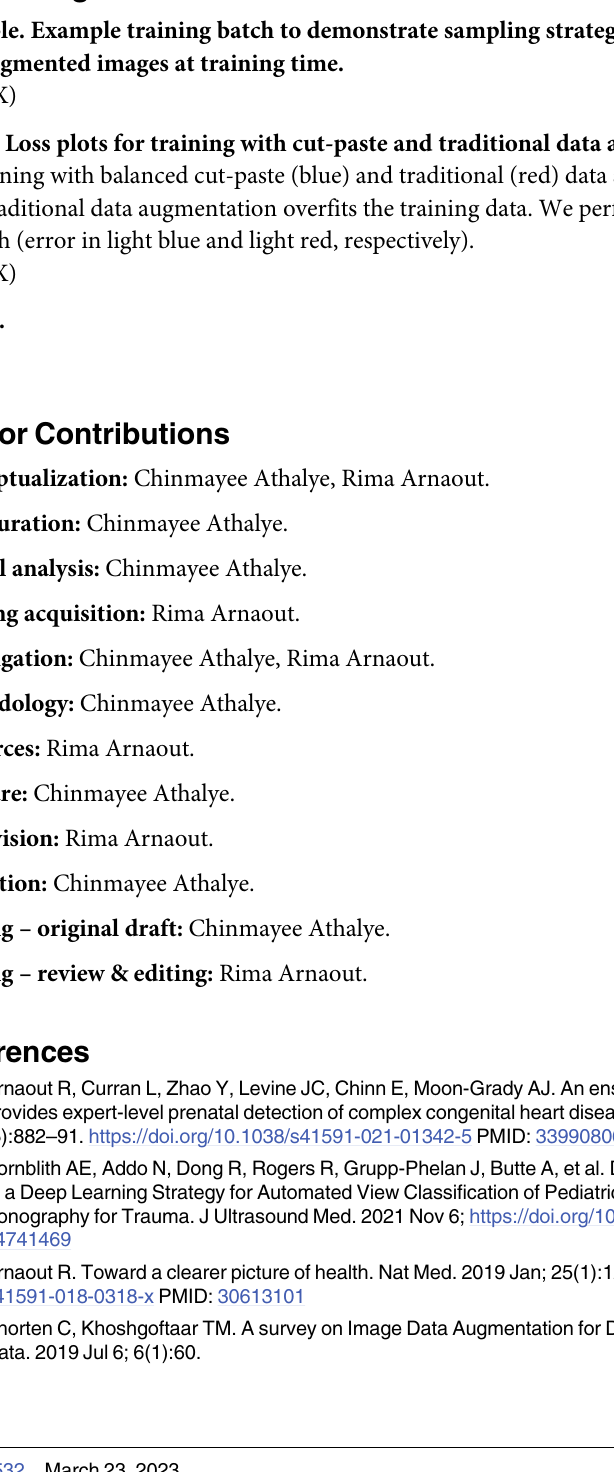
S1 Table. Example training batch to demonstrate sampling strategy for balancing original and augmented images at training time. S1 Fig. Loss plots for training with cut-paste and traditional data augmentation. Loss plots for training with balanced cut-paste (blue) and traditional (red) data augmentation. Training with traditional data augmentation overfits the training data. We performed three replicates for both (error in light blue and light red,